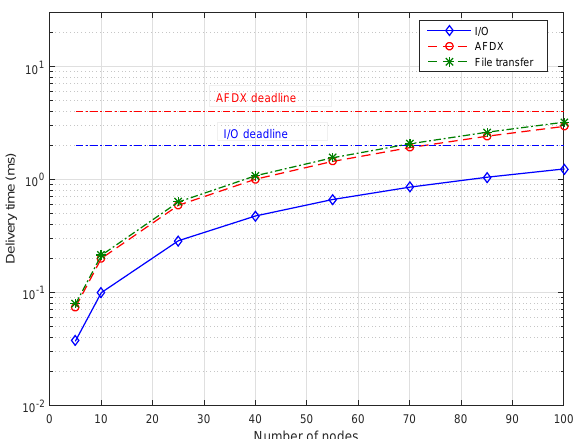
Figure 11. Maximum Delivery Times of AeroRing vs the network size.